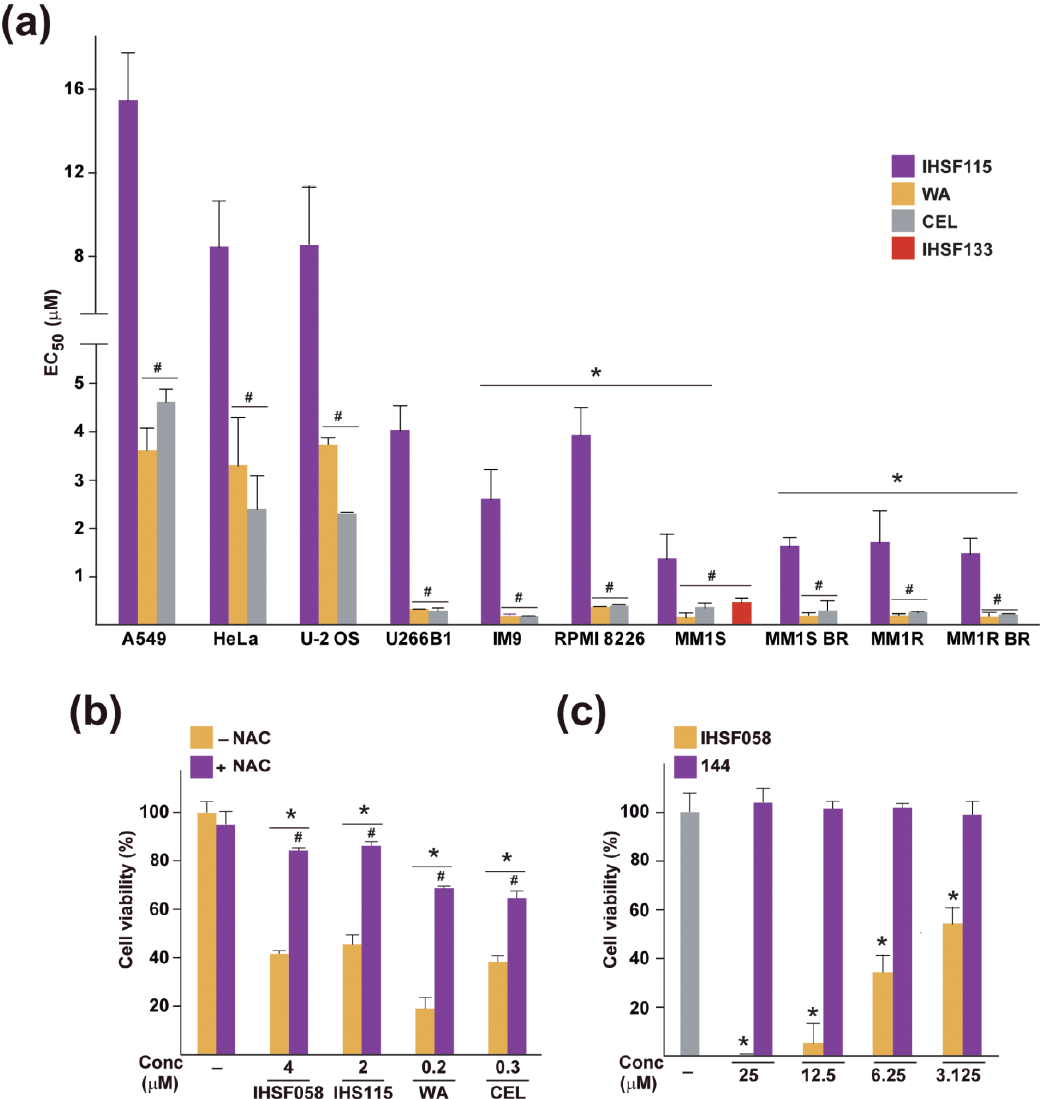
Figure 6. Effects of IHSF, CEL and WA on the viability of MM cell lines and other cancer cell lines. ( a ) EC50 values (50% viability after 96 h of exposure estimated using alamar blue assay) for MM cell lines U266B1, IM9, RPMI 8226, MM1S, MM1R and MM1S BR and MM1R BR cells selected for